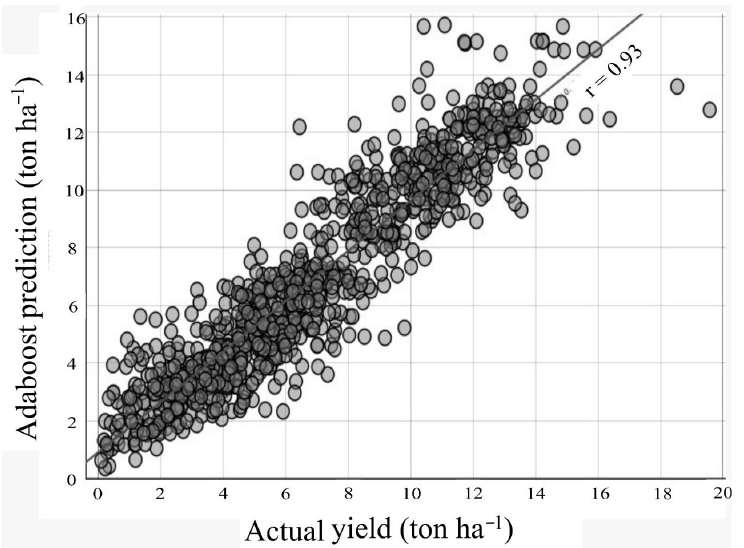
Figure 2. Adaboost regression model relating marketable yield to genetic (cultivar), managerial (planta- tion date, fertilization at planting, and 30 d after planting), tissue test, soil test, and climatic features. Table 1. Random forest yield classification of the training garlic calibration dataset (2015–2017)